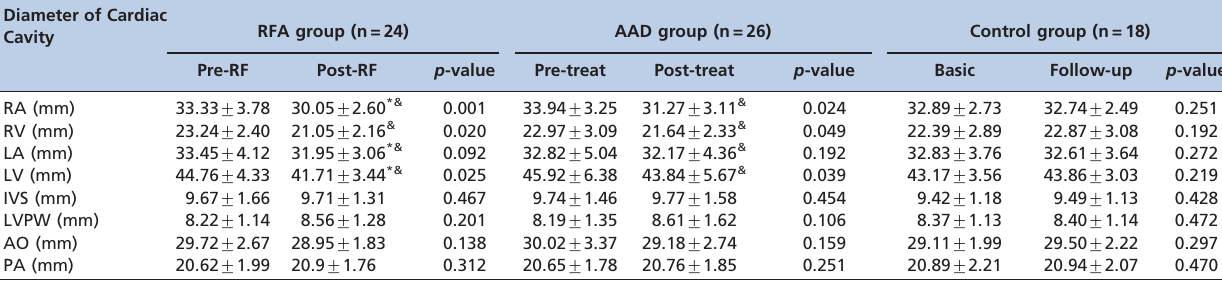
Table 2 - Changes in cardiac cavity diameter in each group. Diameter of Cardiac